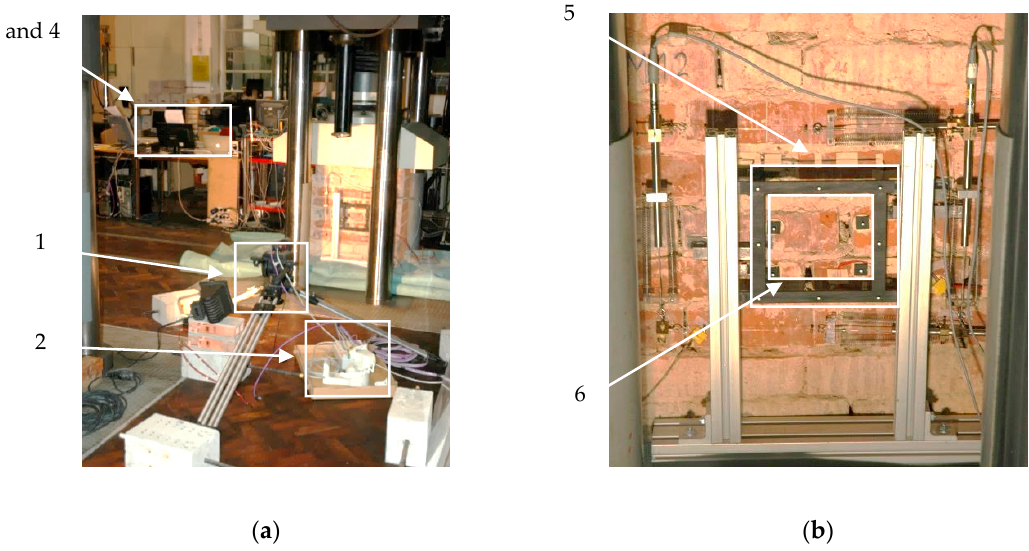
Figure 6. Experimental setup: ( a ) global view; ( b ) classical and optical measurement systems.